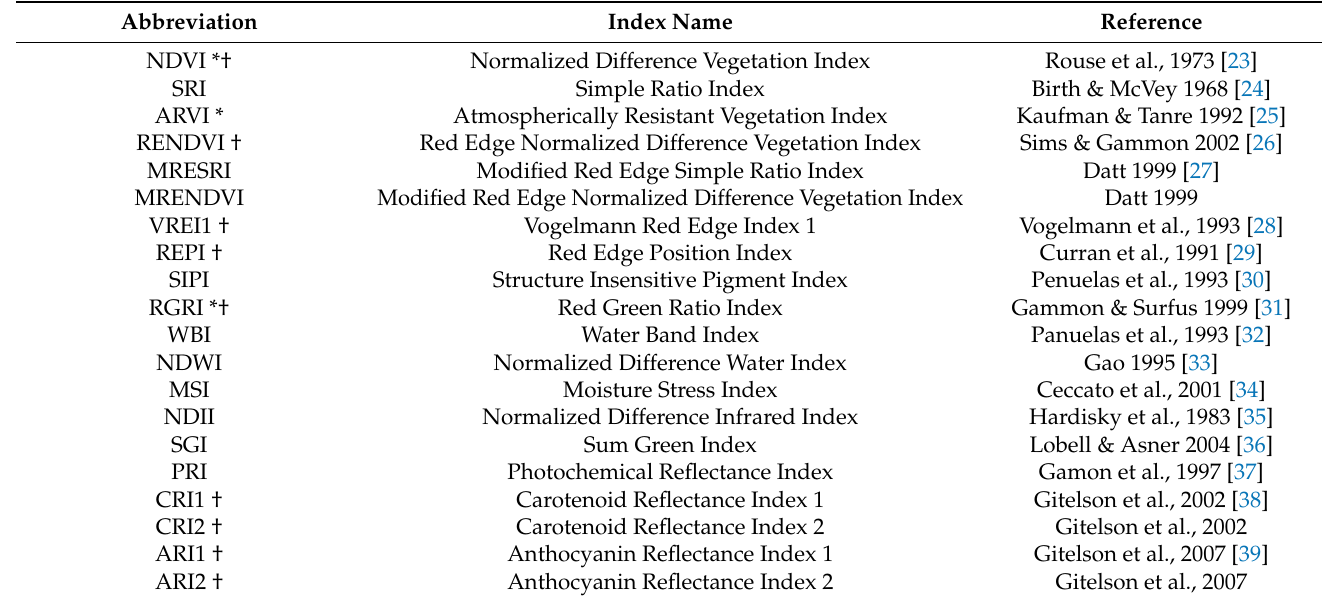
Table 2. List of vegetation indices used in the study. Asterisks (*) indicate a broad-band index. All others are narrow-band. Indices computed for Nordskogen are indicated with a dagger (†). Formulas for all indices can be found in Appendix